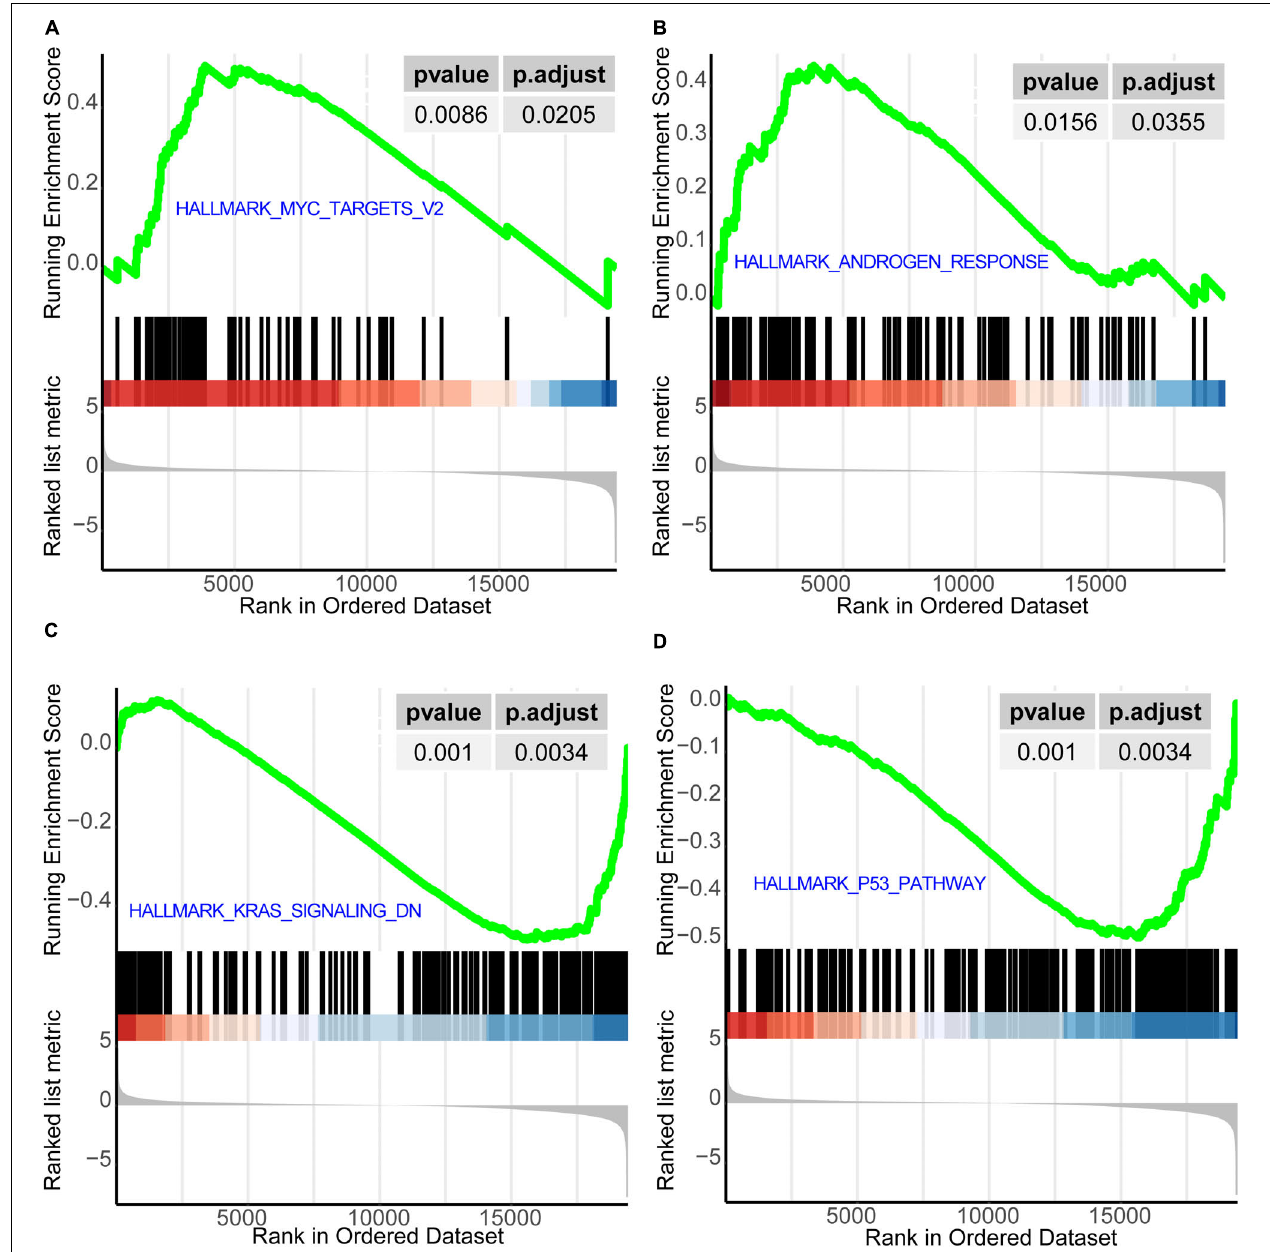
FIGURE 6 | GSEA for consensus clusters. (A) HALLMARK_MYC_TARGETS_V2. (B) HALLMARK_ANDROGEN_RESPONSE. (C) HALLMARK_KRAS_SIGNALING_ DN. (D) HALLMARK_P53_PATHWAY. GSEA, Gene Set Enrichment Analysis.